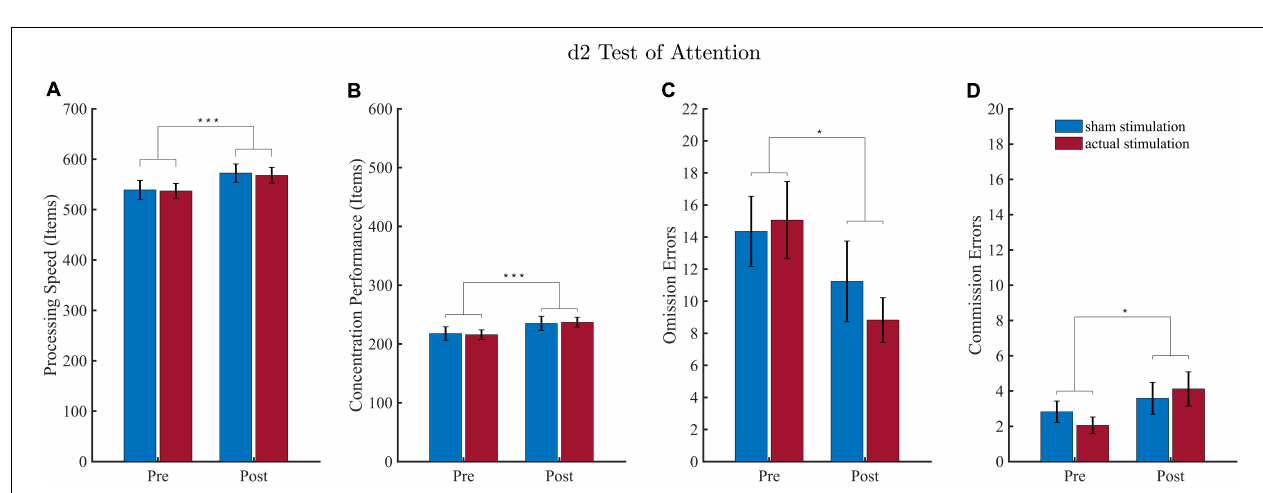
FIGURE 4 | Results of the d2 attention test (d2). Values depict means and SEMs for the sham stimulation (blue bars) and actual stimulation (red bars) before and after intervention. (A) Processing speed depicts the total number of characters processed on average for each condition. (B) Concentration performance depicts the number of correctly identified characters minus all conducted errors averaged for each condition. (C , D) Number of omission and commission errors averaged for each condition. * p < 0.05, ***p < 0.001.